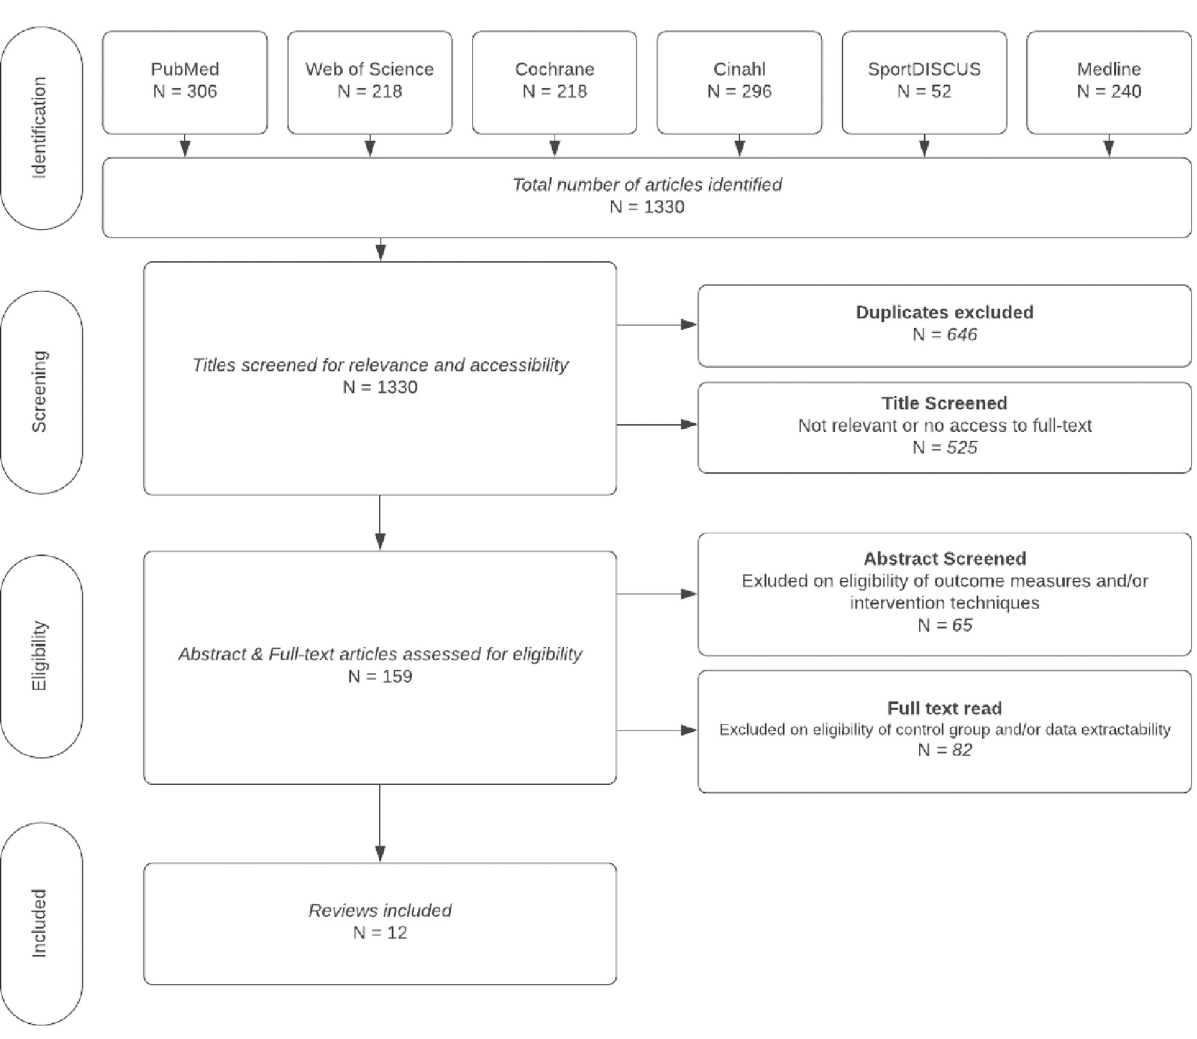
Fig 1. PRISMA. PRISMA flowchart indicating the study selection